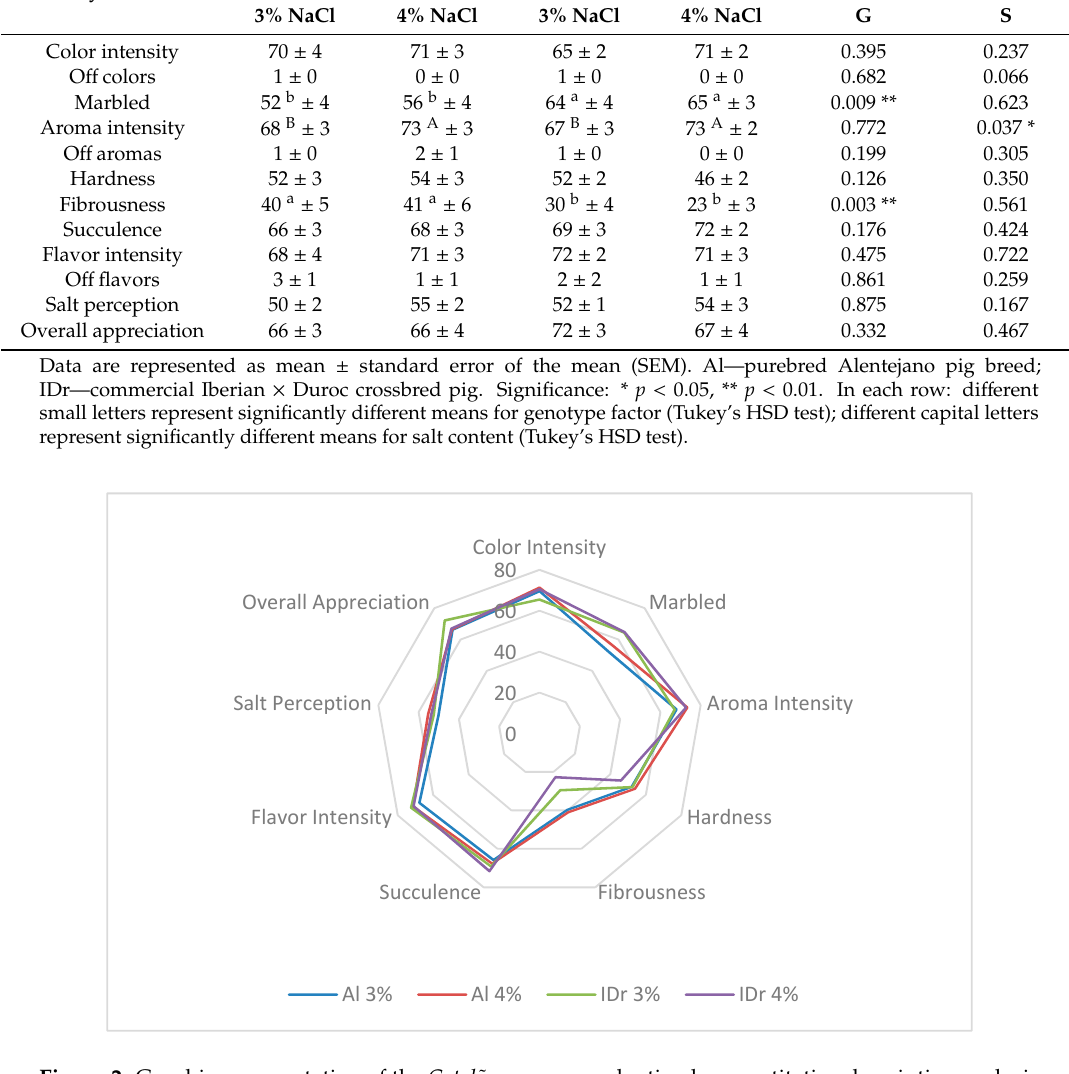
Table 5. Influence of pig genotype and salt content in the sensory evaluation of Catal ã o . Sensory Attributes